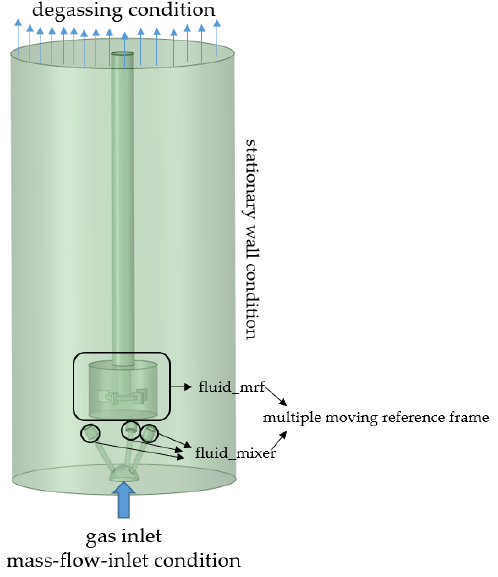
Figure 9. Boundary conditions and cell zones of the domain.